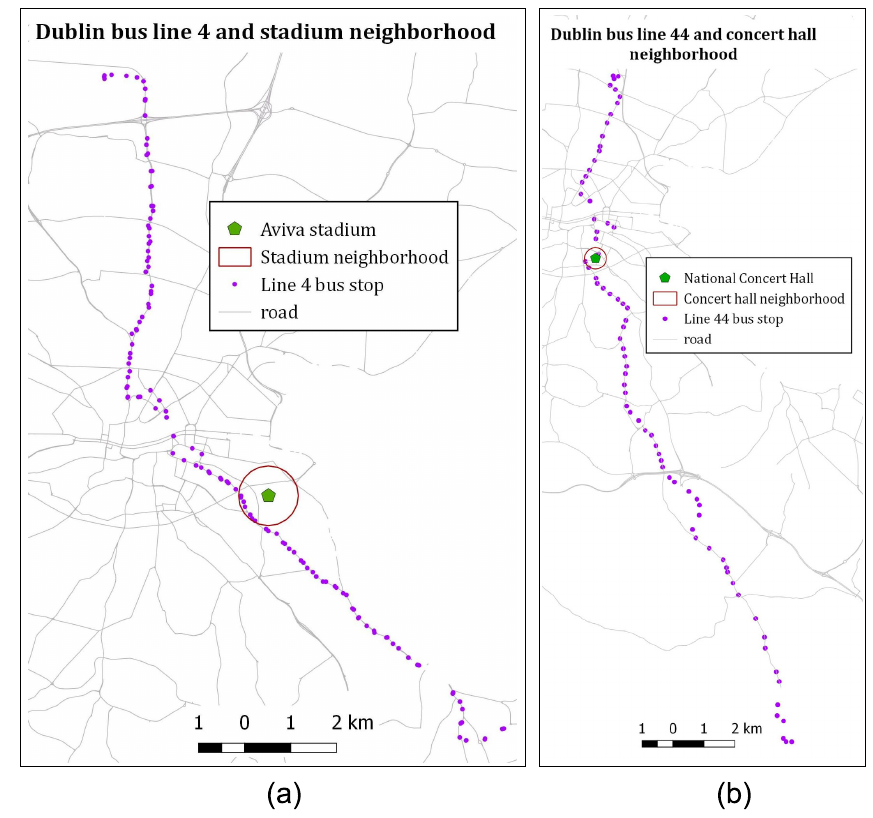
Figure 3. Location of context elements: ( a ) line 4 bus stops and Aviva stadium; and ( b ) line 44 bus stops and the National Concert hall.